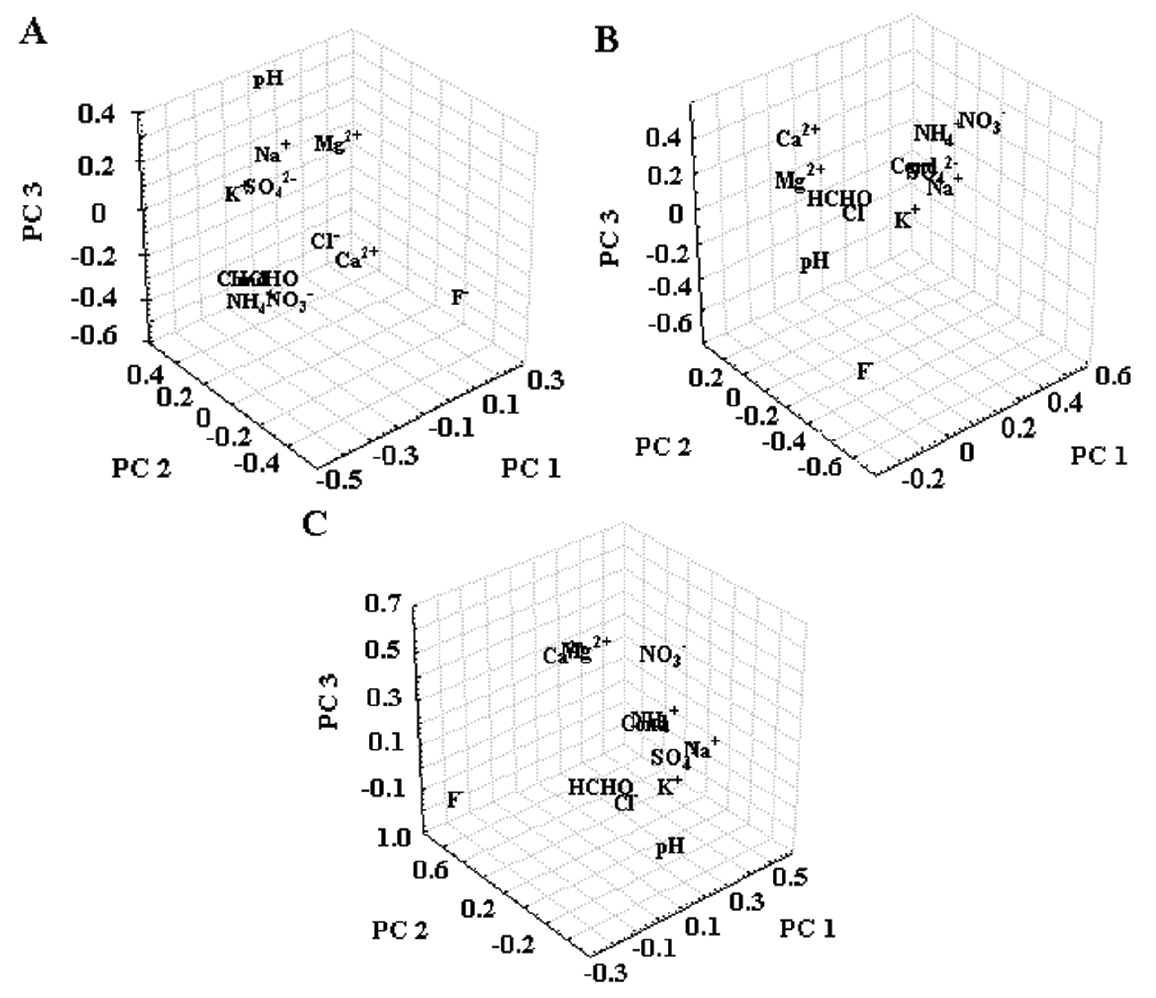
Figure 4. PC1-PC2-PC3 loading plot: A-classical PCA; B-FPCA-1;